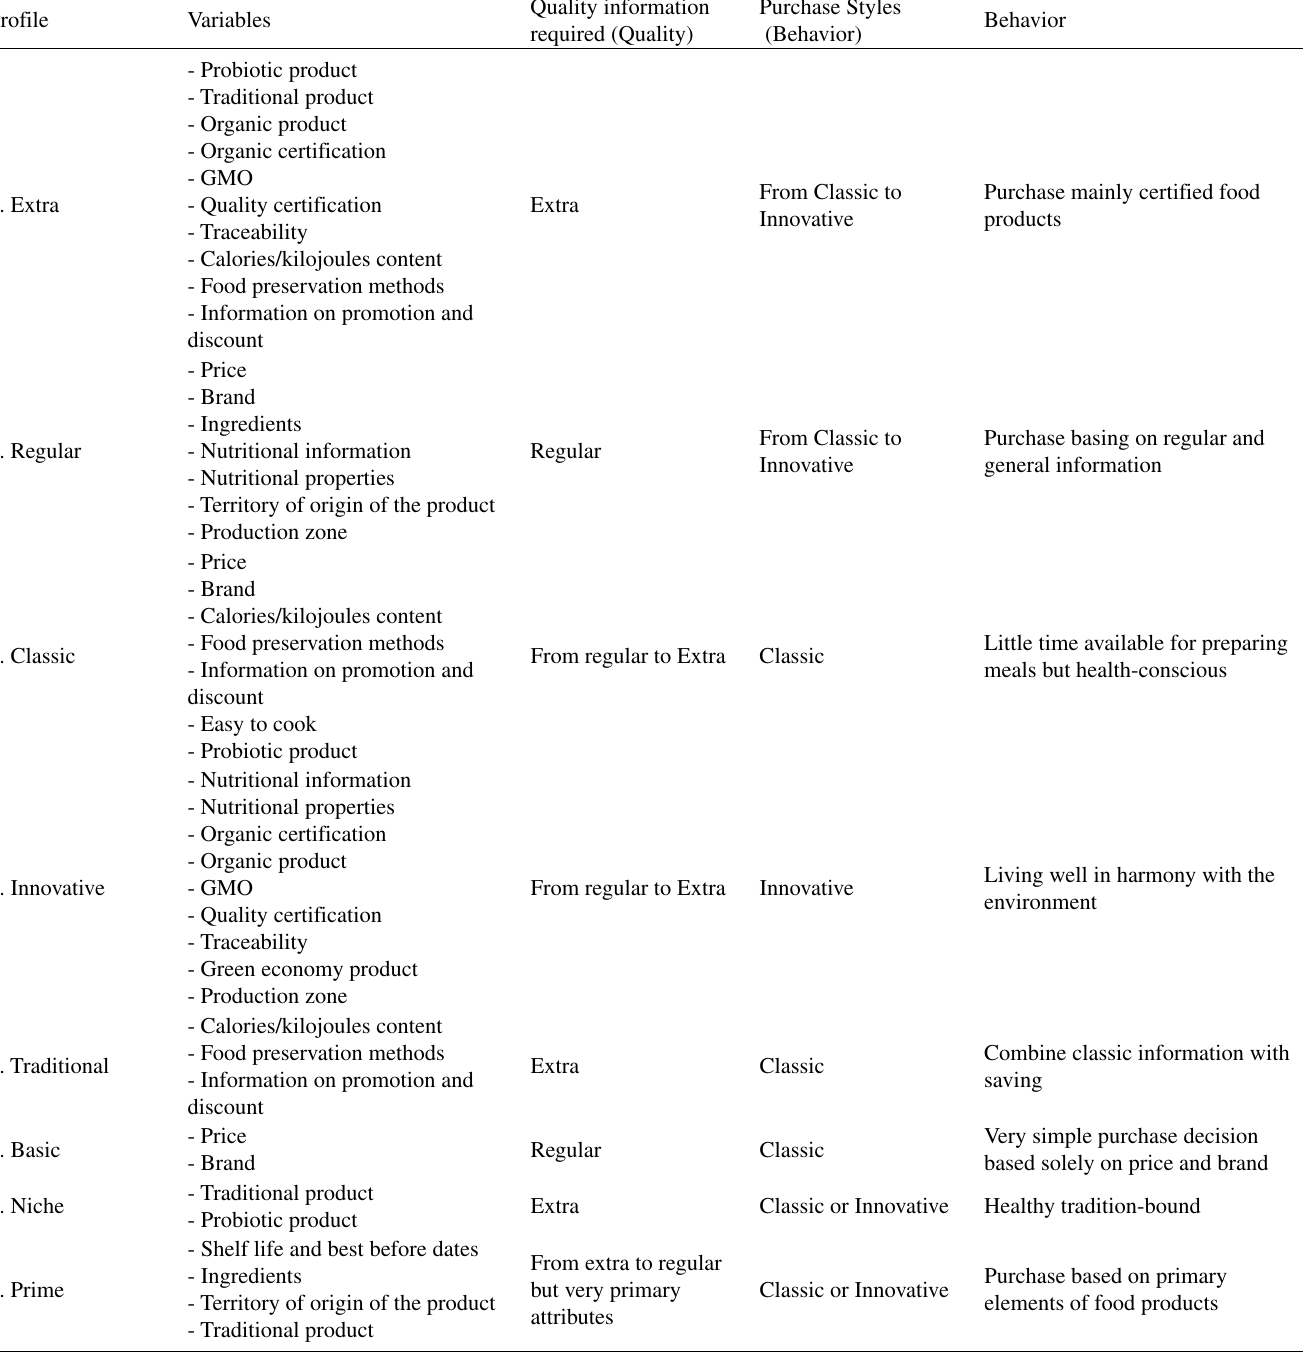
Table 4 - Characteristics of discovered profiles Profile